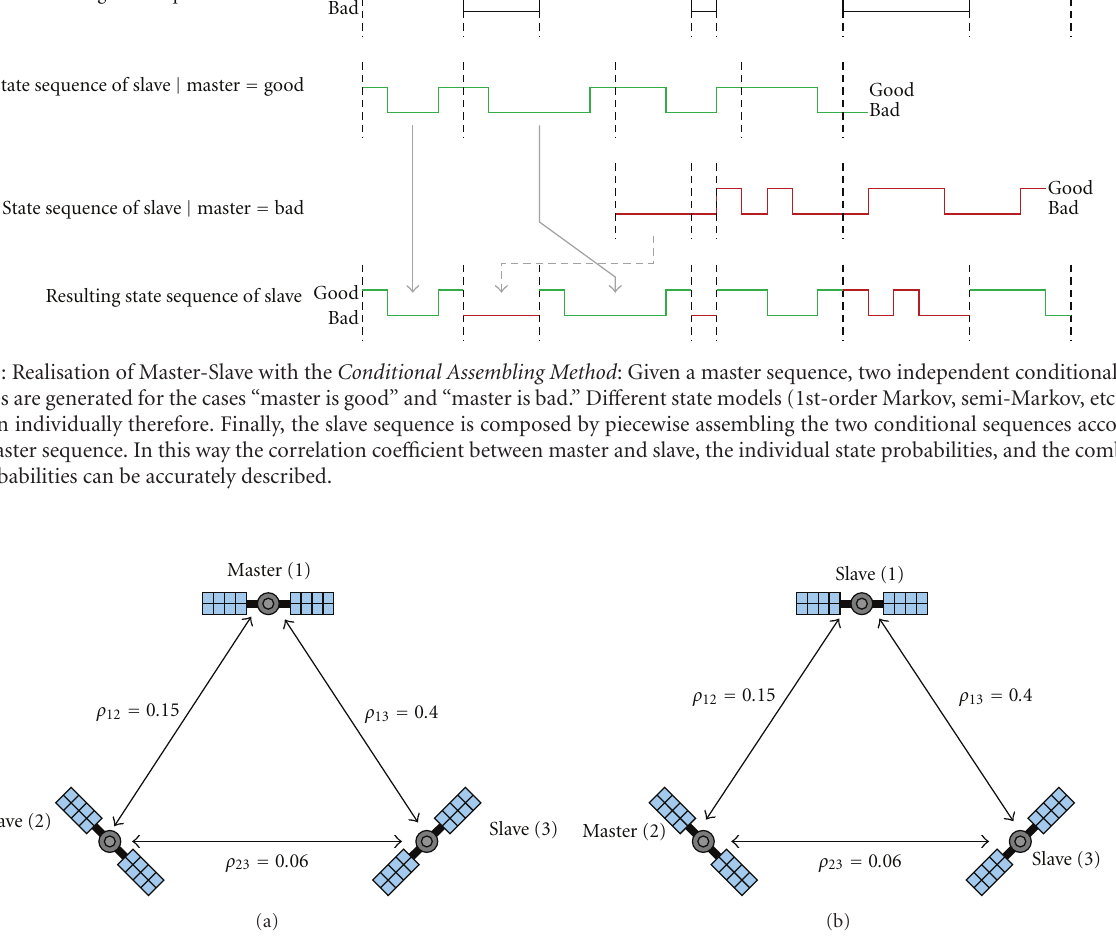
Figure 4: (a) Appropriate mapping of a three-satellite constellation for the Master-Slave approach (Mapping 1)—the correlation between the slaves is low. (b) Inappropriate mapping of the three-satellite constellation (Mapping 2)—the correlation between the slaves is